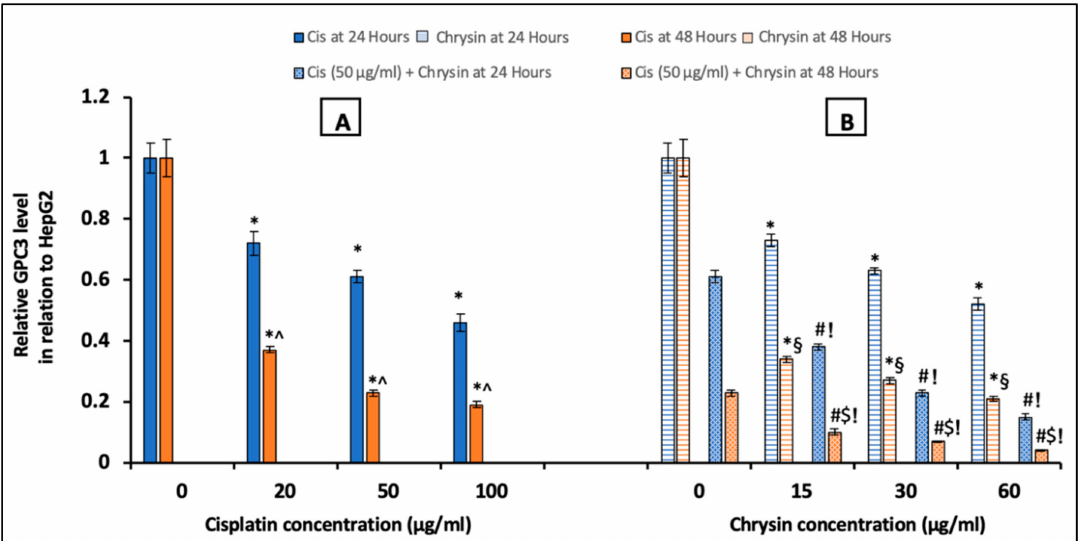
Figure 2. Impact of 24 and 48 h treatment with ( A ) cisplatin (Cis; 20, 50, 100 µ g / mL), ( B ) chrysin (15, 30, 60 µ g / mL) and combination of chrysin (15, 30, 60 µ g / mL) with Cis 50 µ g / mL on glypican-3 (GPC3) protein levels in HepG2 cells. Results are presented as Mean ± SD. * p < 0.05 versus the control untreated cells. ˆ p < 0.05 versus the same dose of Cis treatment for 24 h. # p < 0.05 versus the same dose of chrysin at the same incubation time. ! p < 0.05 versus Cis 50 µ g / mL at the same incubation time. § p < 0.05 versus the same dose of chrysin treatment for 24 h. $ p < 0.05 versus cis 50 µ g / mL + the same dose of chrysin treatment for 24